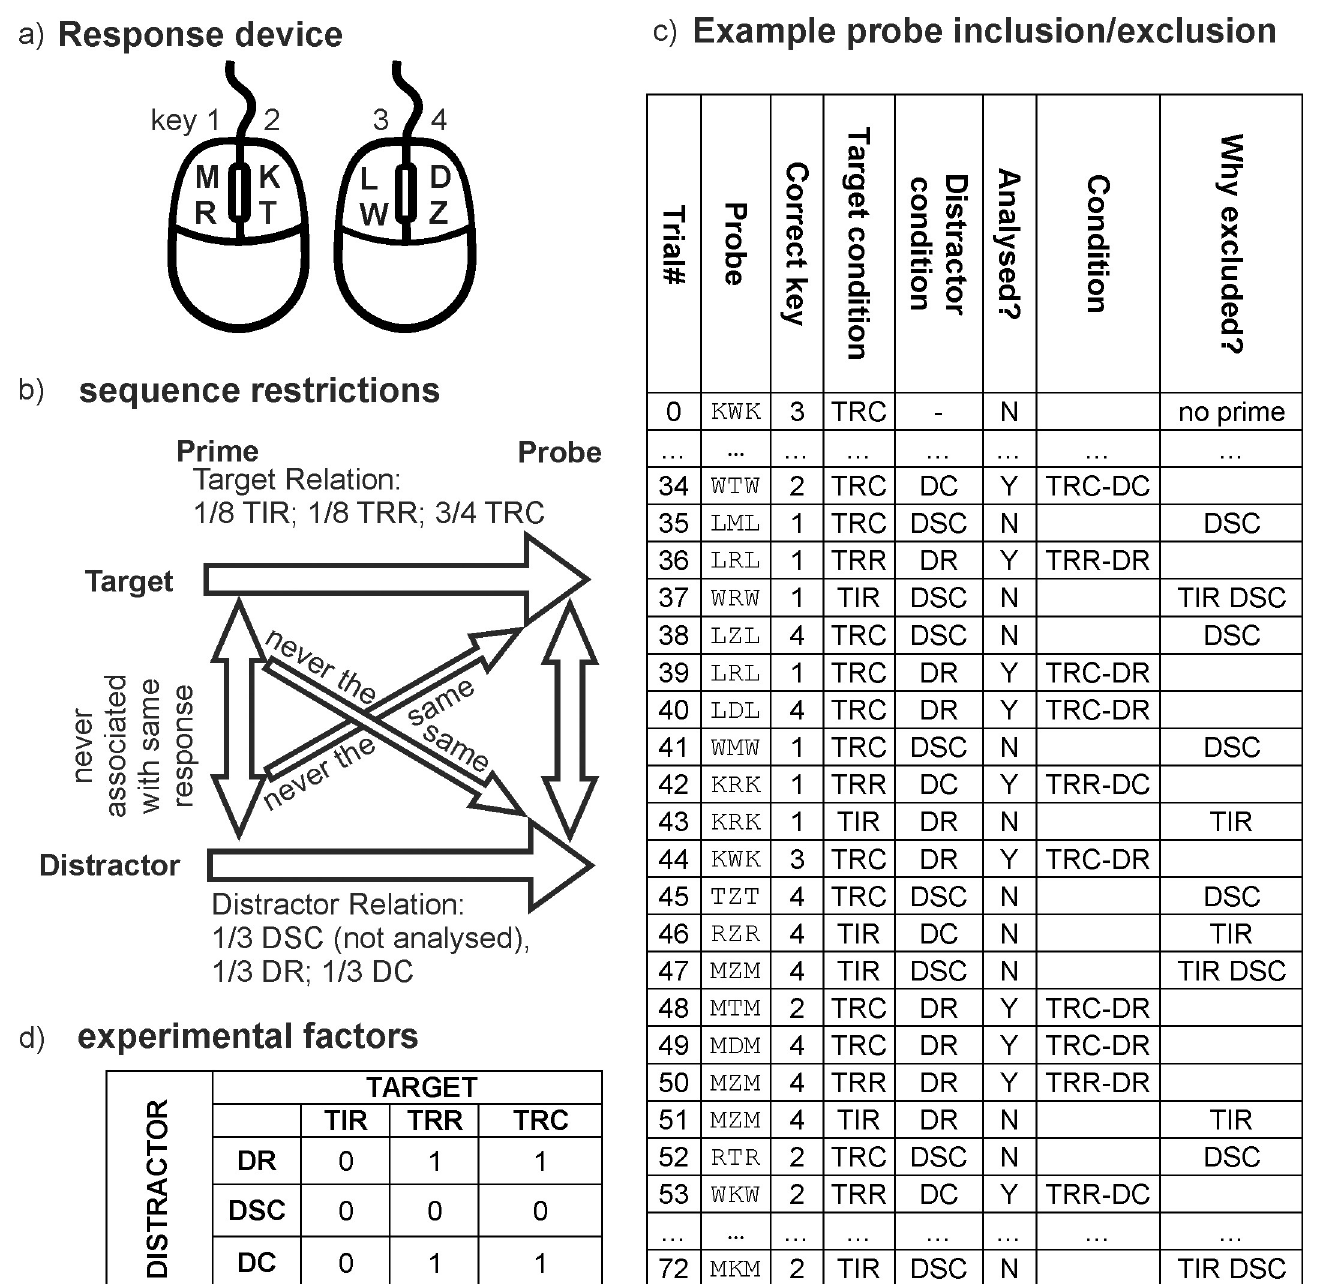
Fig 1. Description of the flanker task. (A) response device with 8-letters to 4-button-matching. (B) sequence restrictions. prime-probe-sequences regarding target-distractor-relation and prime-probe-relation. Target relation: TIR = Target Identity Repetition (identical target in prime and probe), TRR = Target Response Repetition (prime and probe target were different in identity, but were mapped on the same response button), TRC: Target Response Change (prime and probe target were associated with different responses). Distractor relation: DSC = Distractor Same Category (distractor in prime and probe were different, but associated with the same response), DR = Distractor Repetition from prime to probe; DC = Distractor Change (distractors in prime and probe were associated with different responses). See text for detailed explanation of sequence restrictions. (C) a fraction of a possible block, indicating included and excluded trials. abbreviations same as in b. Y = Yes, N = No. (D) experimental factors. 0 = excluded from analysis, 1 = analysed. abbreviations as in